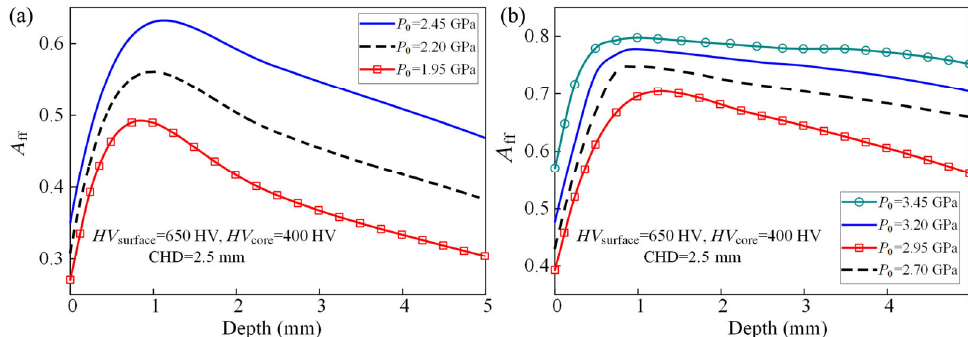
A under different P 0 cases: cases with purely elastic response (a), and the cases with plasticity response Fig. 15 ff